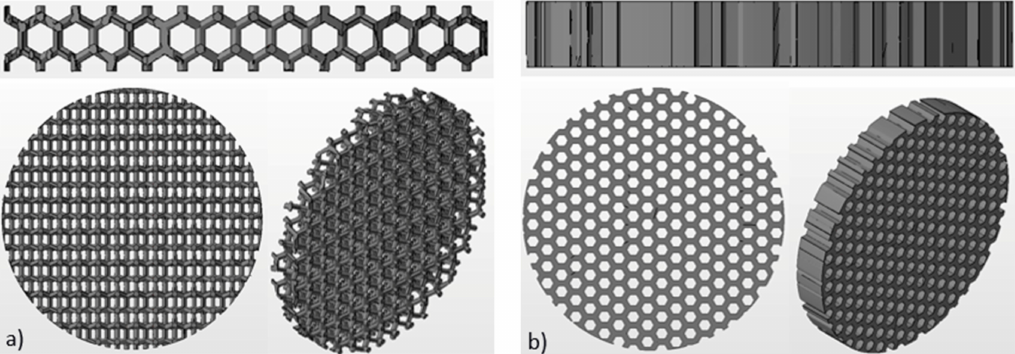
Figure 2. Schematic images of 3D structure used for the fabrication of Ti-disks: ( a ) wurtzite and ( b ) honeycomb. Disks have the diameter of 15 mm and are 2 mm thick.